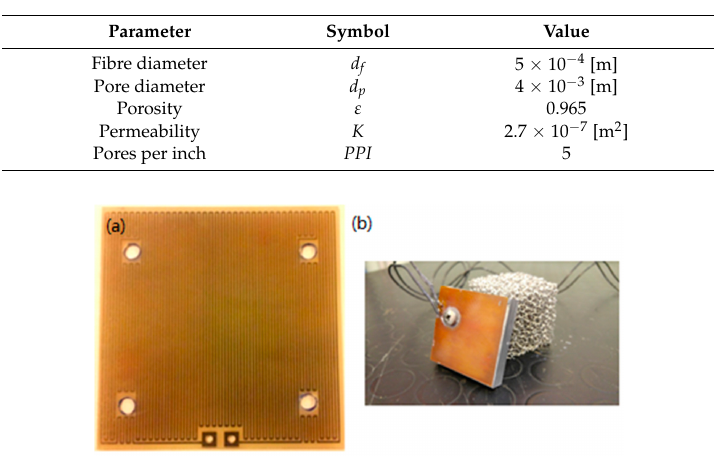
Table 1. Geometrical and physical parameters for the employed aluminum foam samples.